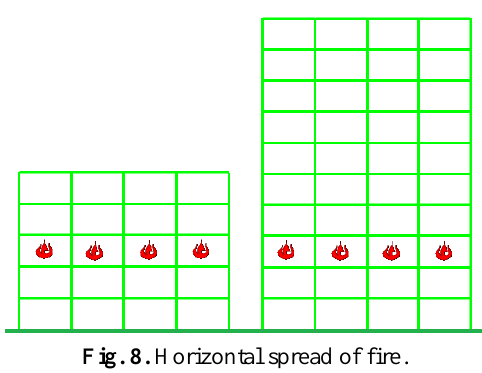
Fig. 8. Horizontal spread of fire.